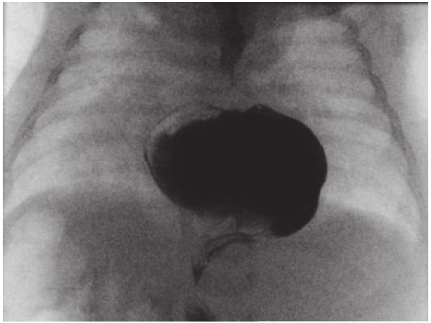
Figure4: Definitive imaging (upperGIseries)showingthemajority of the stomach above the